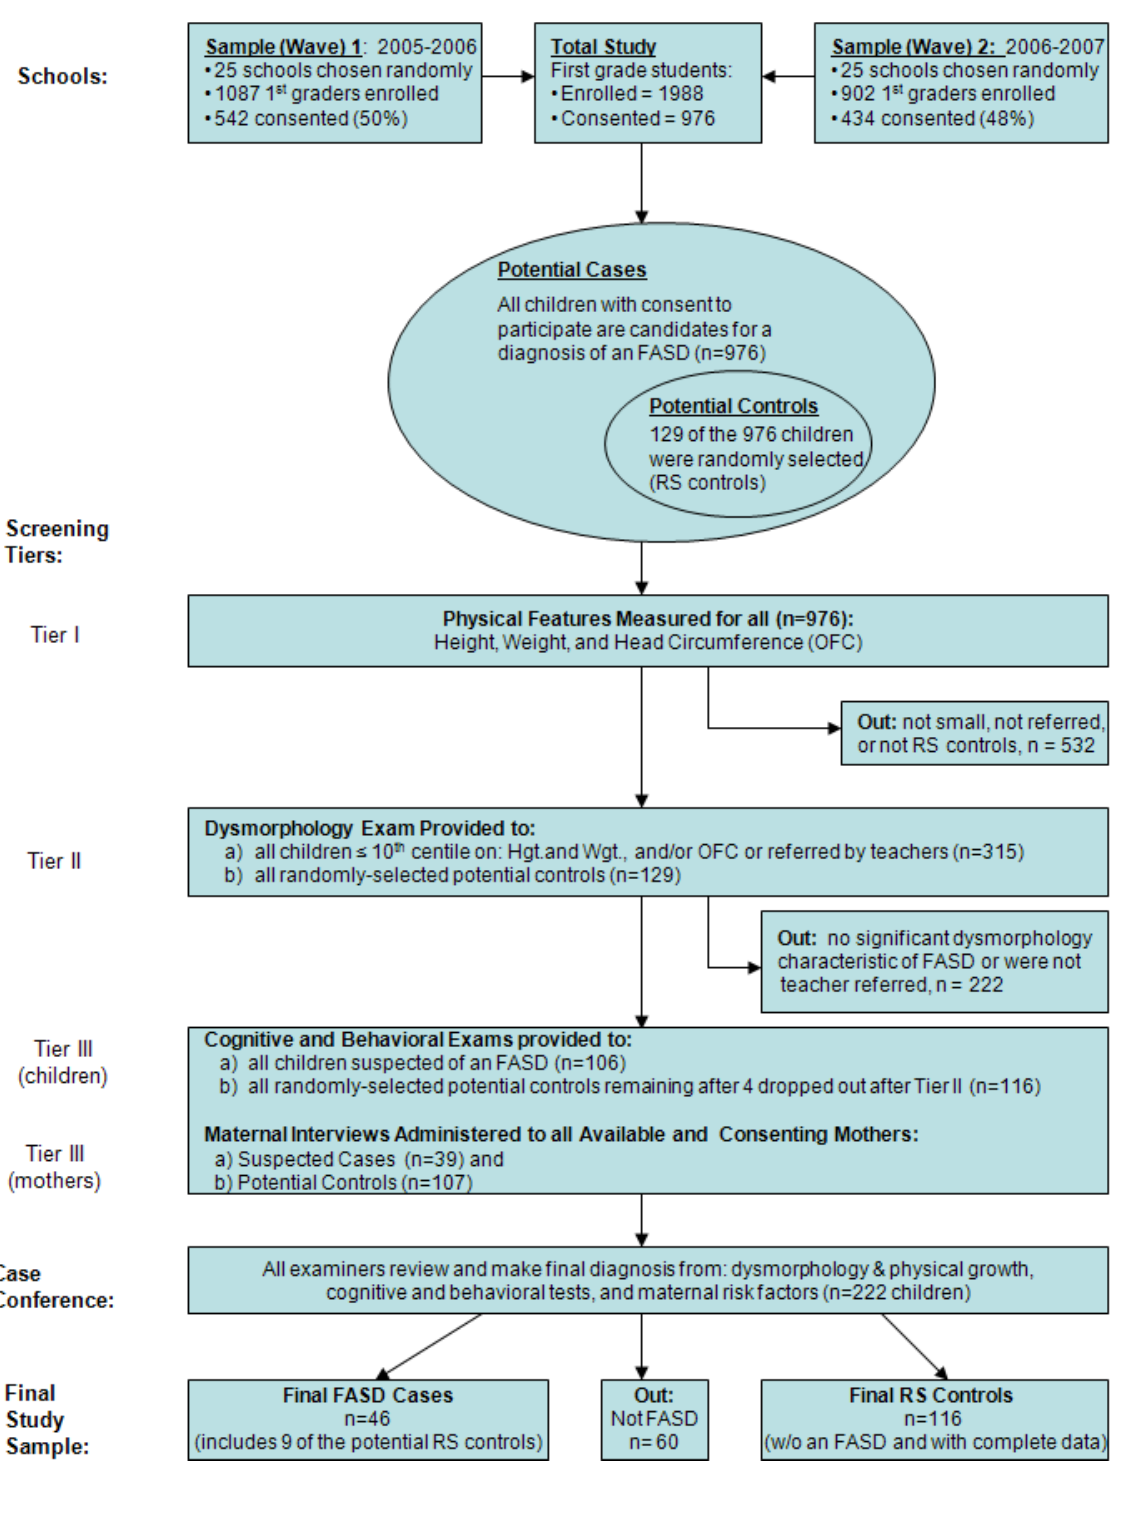
Figure 1. Methodology of the Lazio Region (Italy) FASD study with Sampling Procedures and